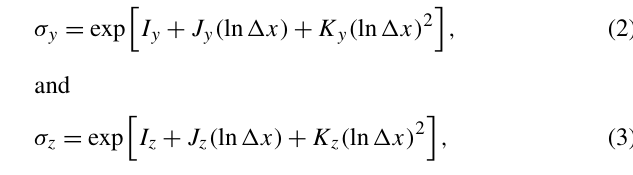
over the reference path 2